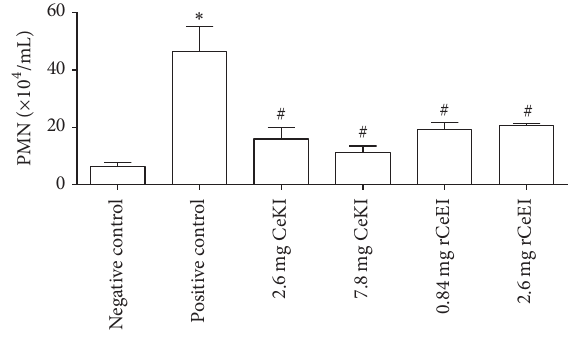
Figure 1: PMN quantification in BALF. Rats were pretreated intravenously with buffer (negative or positive controls), CeKI (7.8 or 2.6mg), or rCeEI (2.6 or 0.84 mg). After 20 min, they received 75 𝜇 g LPS/animal (positive control and CeKI and rCeEI groups) or buffer (negative control) injected via the trachea directly into their lungs. Six hours later, lungs were collected and washed with buffer (BALF). BALF (20 𝜇 L) was mixed with 0.4% Trypan Blue. Total and differential leukocyte cells were counted manually with a Neubauer chamberusingopticalmicroscopy. ∗ Significantdifferencecompared to negative control (𝜌 < 0.05) . # Significant difference compared to positive control (𝜌 < 0.05)